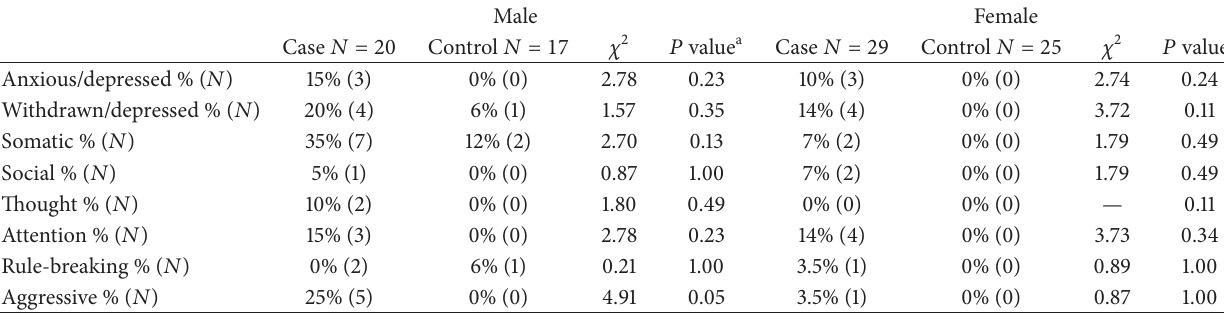
Table 6: Percentage of CAH patients with clinical range scores on syndrome scales compared to the controls.